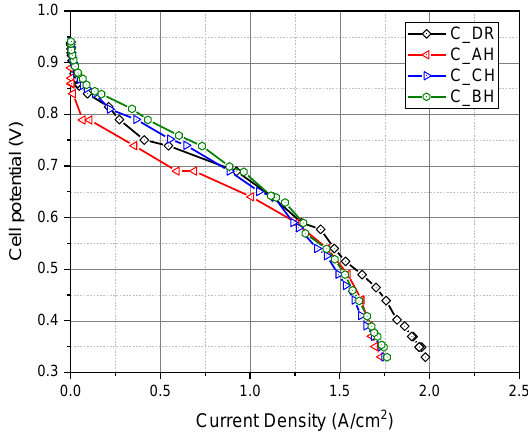
Figure 6. Variation of PEFC voltage with channels for various humidification conditions.